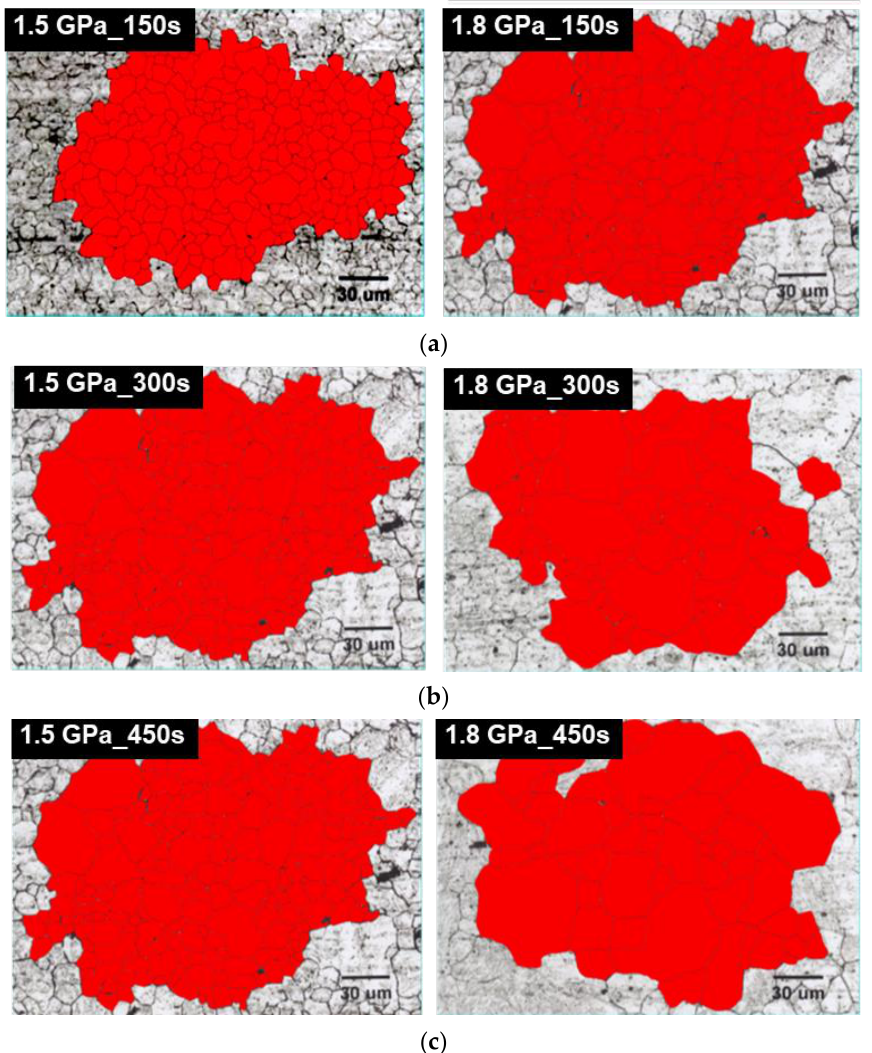
Figure 5. The OM images showing prior austenite grains in both 1.5 GPa grade and 1.8 GPa grade steels austenitized at 1203 K for ( a ) 150 s, ( b ) 300 s, and ( c ) 450 s. Table 5. Variations of prior austenite grain size as a function of austenitizing time at 1203 K in 1.5 GPa grade and 1.8 GPa grade steels.